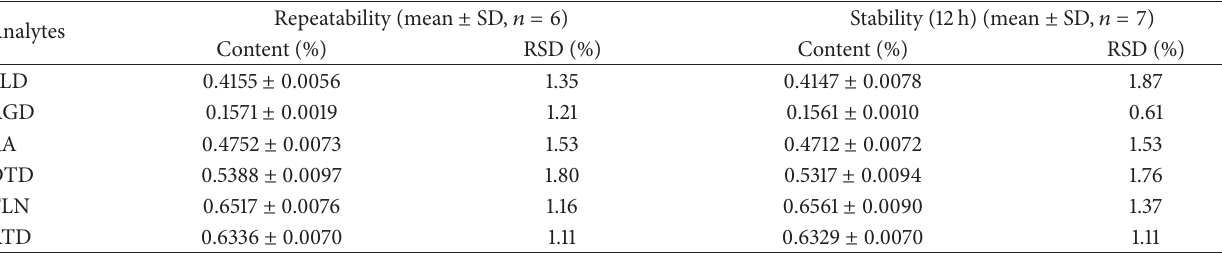
Table 5: Repeatability and stability for the investigated analytes.